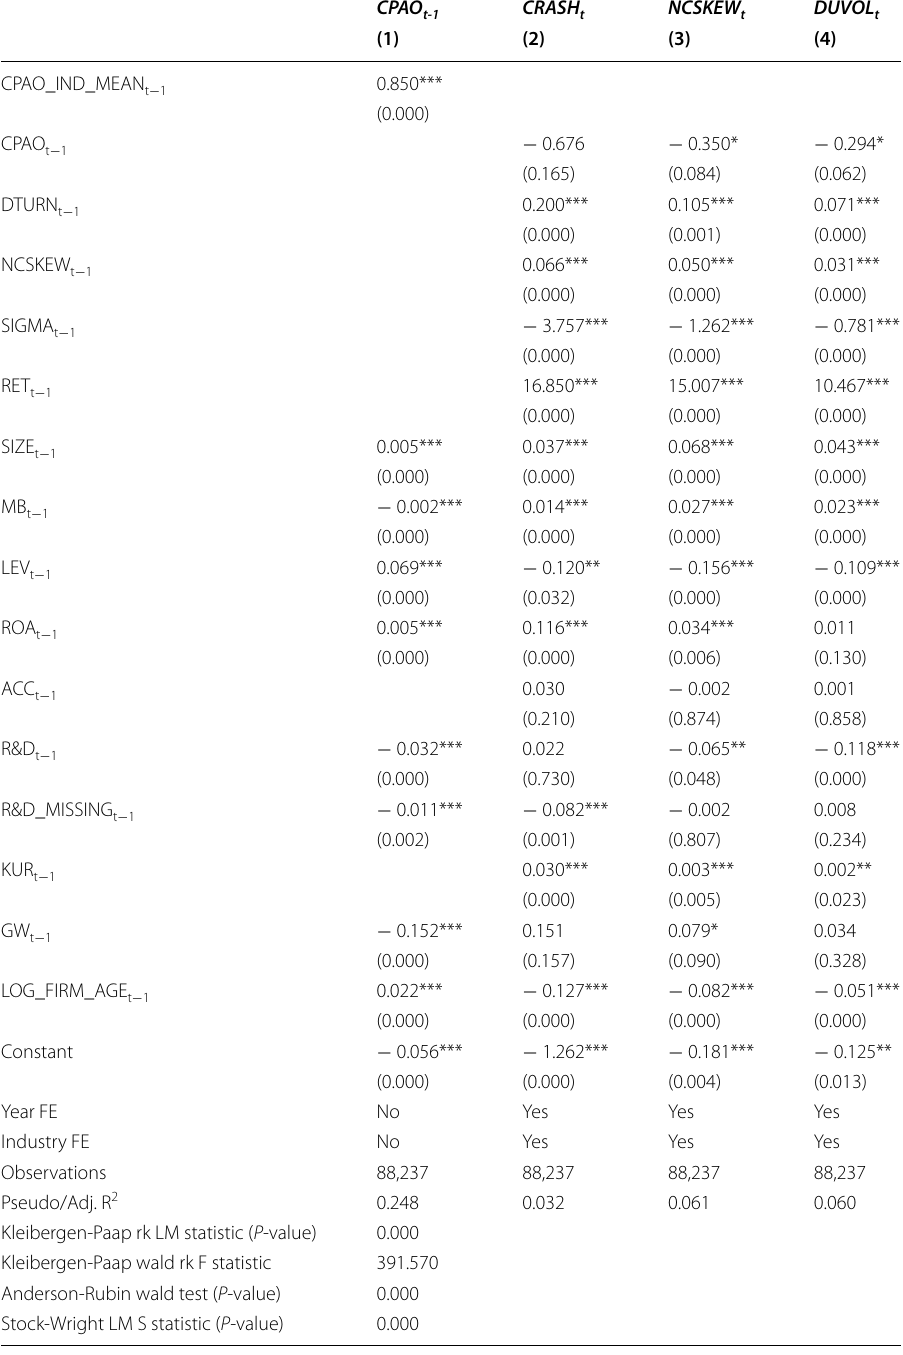
Table 3 Instrumental variable